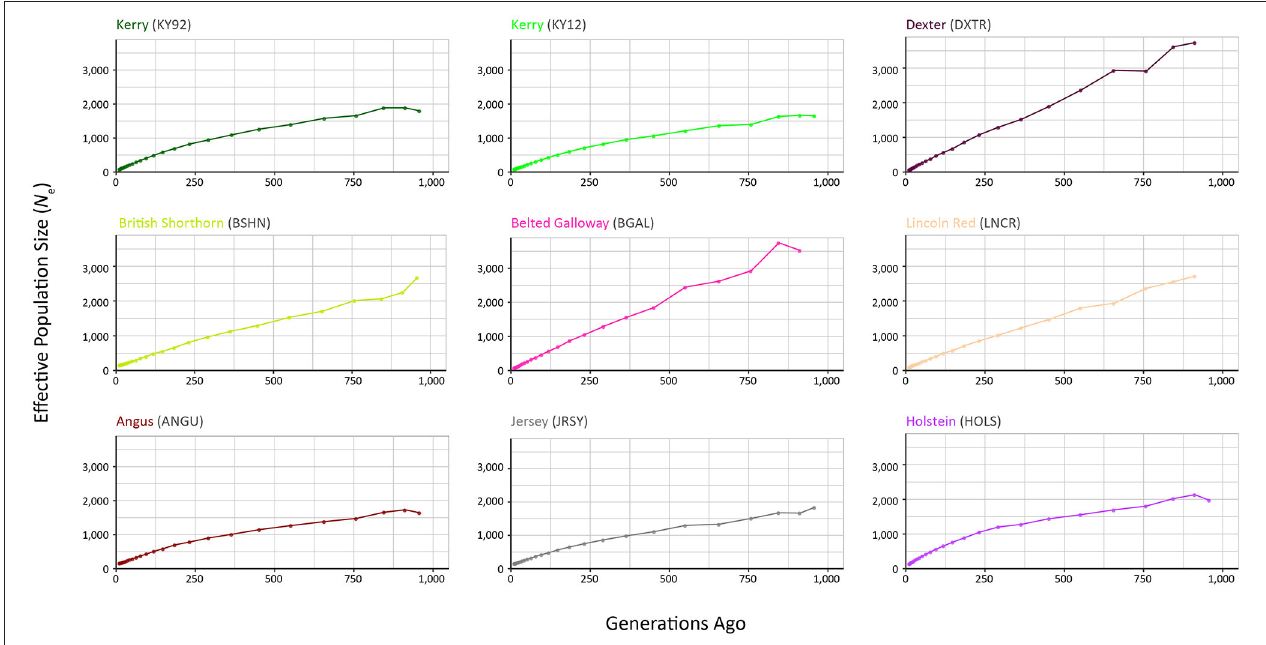
FIGURE 8 | Genetic effective population size ( N e ) trends modelled using genome-wide SNP data. Results for the KY92 and KY12 populations are shown with seven comparator heritage and production cattle